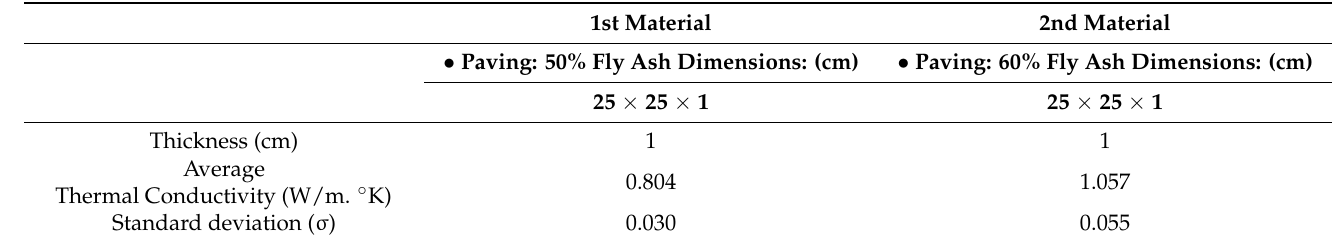
Table 3. The results of thermal